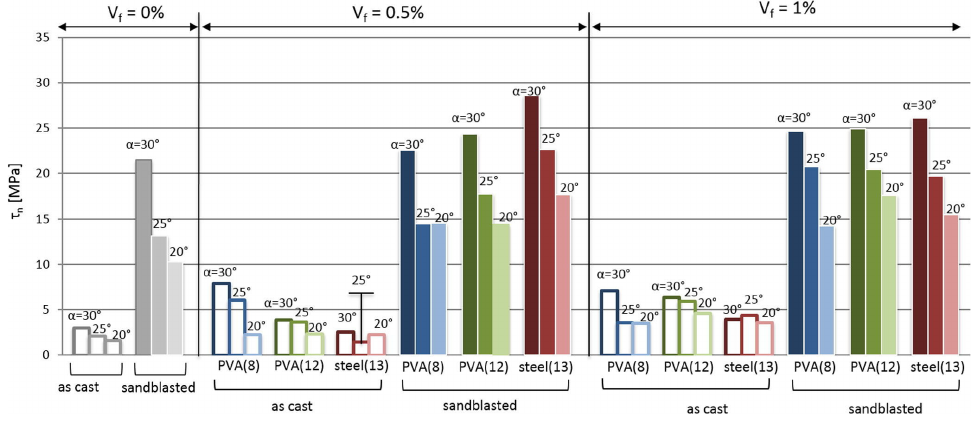
Figure 16. Effect of fiber on the shear bond strength between fiber reinforced concrete and concrete substrate (substrate–repair shear bond strength: τ n , plotted as a function of the fiber volume fraction in the repair mortar; V f , the bond plane inclination; α , the substrate treatment: sandblasted or “as cast”; the type of fiber reinforcement: PVA or steel (13 mm) [79].) (Adapted and reprinted with permission from ref. [79], © 2018, Construction and Building Materials ).